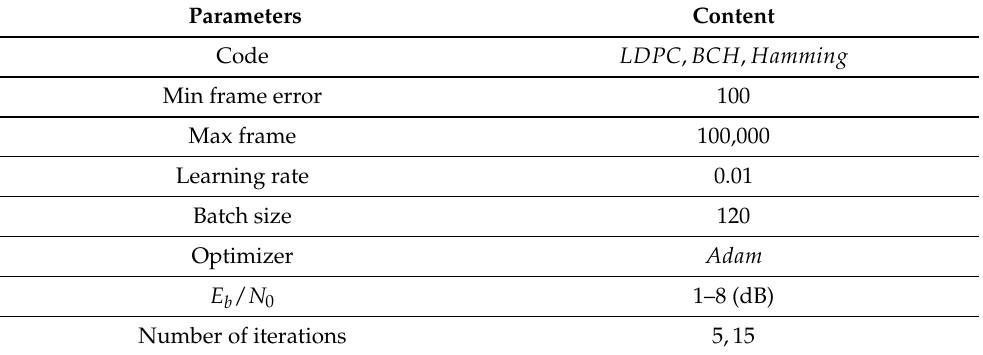
Table 1. Parameters of